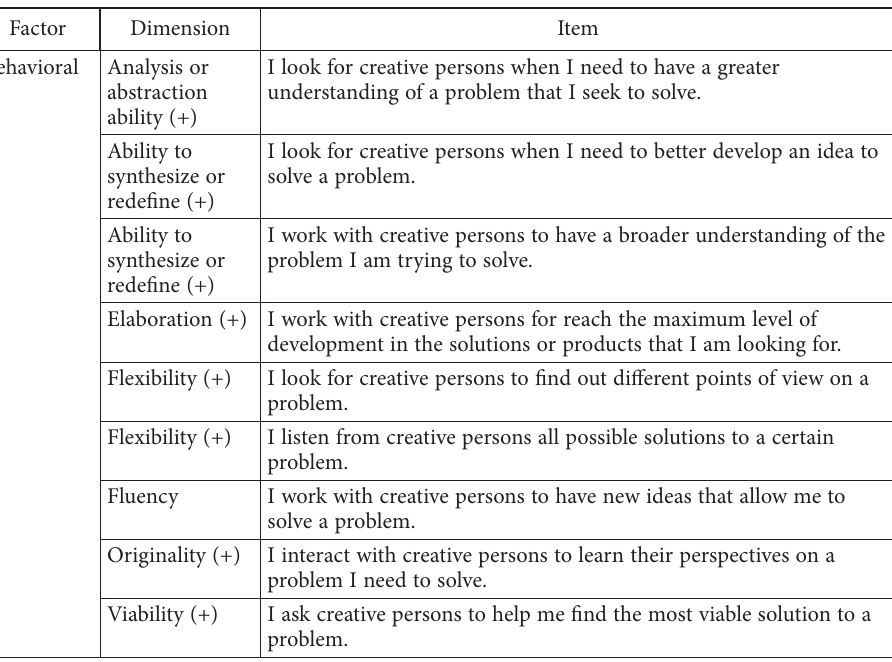
Table 3. Final version of attitudes towards creative persons (source: created by